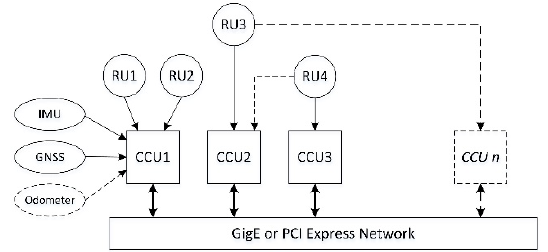
Figure 1 . The general scheme of VS hardware and traditional information systems combination for mobile robots information support. RU – recording unit (video camera) with a certain field of view; CCU – computing control unit; GNSS – global navigation satellite system.